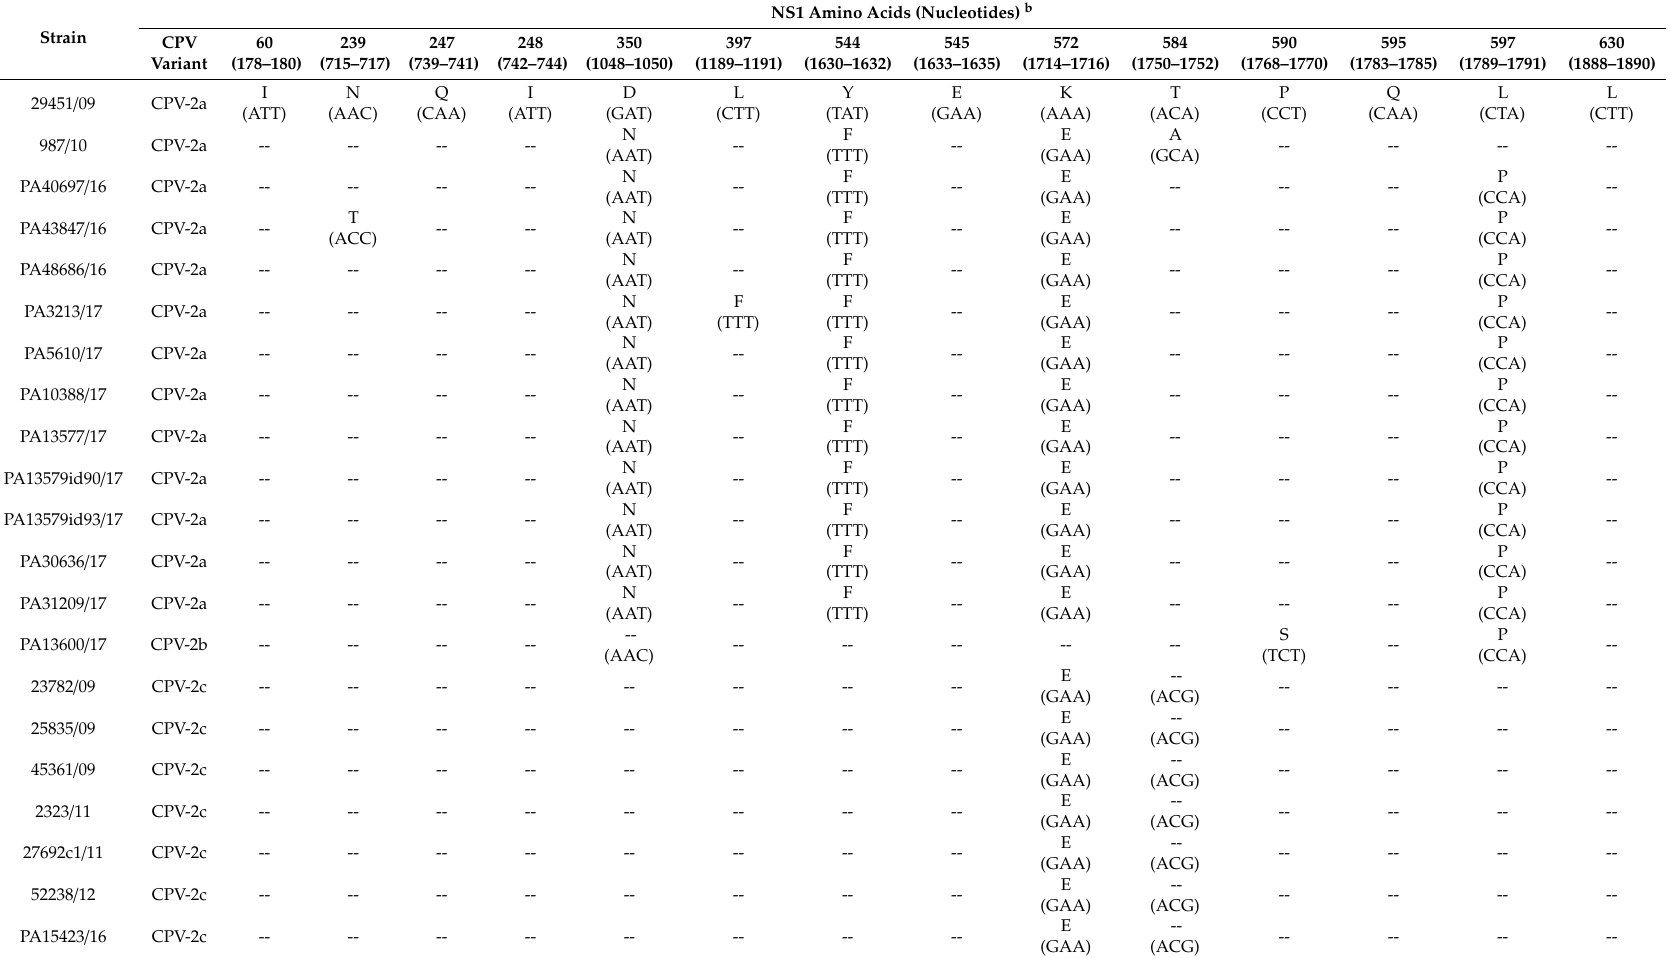
Table 3. NS1 non-synonymous changes of analyzed CPV strains described in this